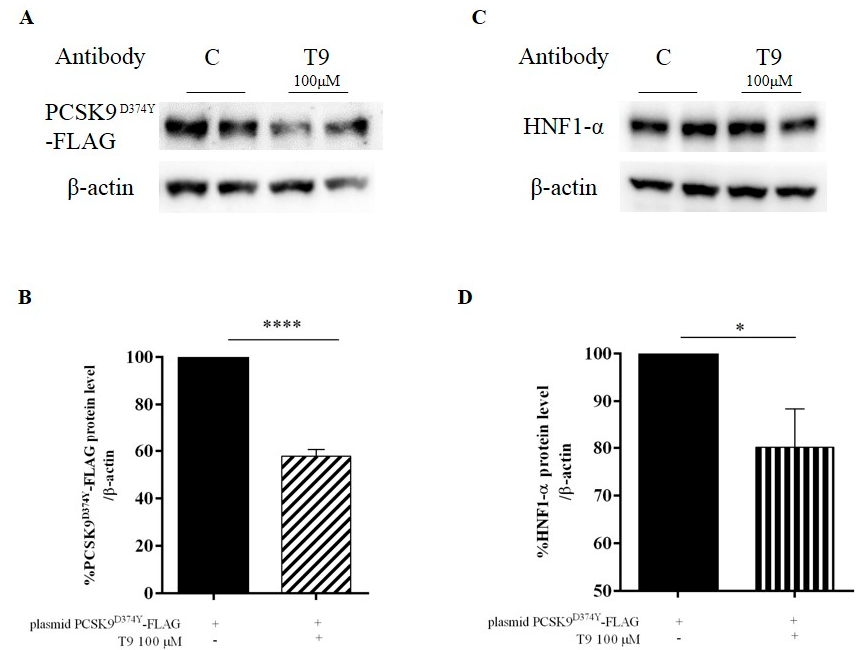
Figure 2. Effects of T9 on PCSK9 D374Y -FLAG ( A,B ) and HNF-1 α ( C,D ) protein levels. Transfected HepG2 cells were incubated with T9 for 24 h. PCSK9 D374Y -FLAG, HNF-1 α , and β -actin were detected using specific anti-FLAG, anti-HNF-1 α , and anti- β -actin primary antibodies, respectively. Each protein signal was quantified and normalized with β -actin signals. The data points represent the averages ± S.D. of four independent experiments in duplicate. (*) p < 0.05, (****) p < 0.0001 vs. untreated transfected samples (C: control cells).